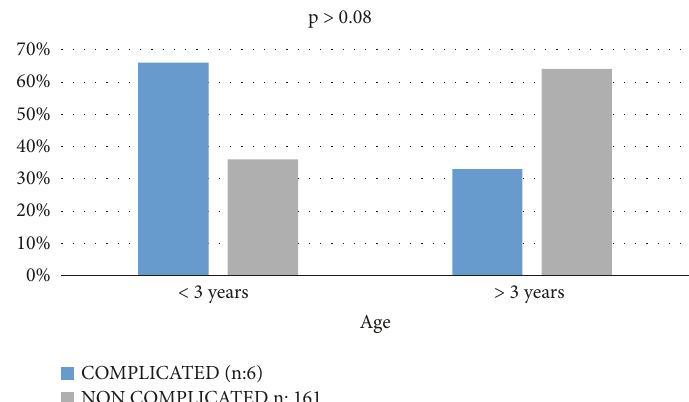
Figure 1: Comparison betweengroups of age . Patients younger than 3 years, compared to patients older than 3 years, had a higherincidence respiratory complications in the immediate and early postoperative care. There was no significant difference between both groups (p > 0.08).